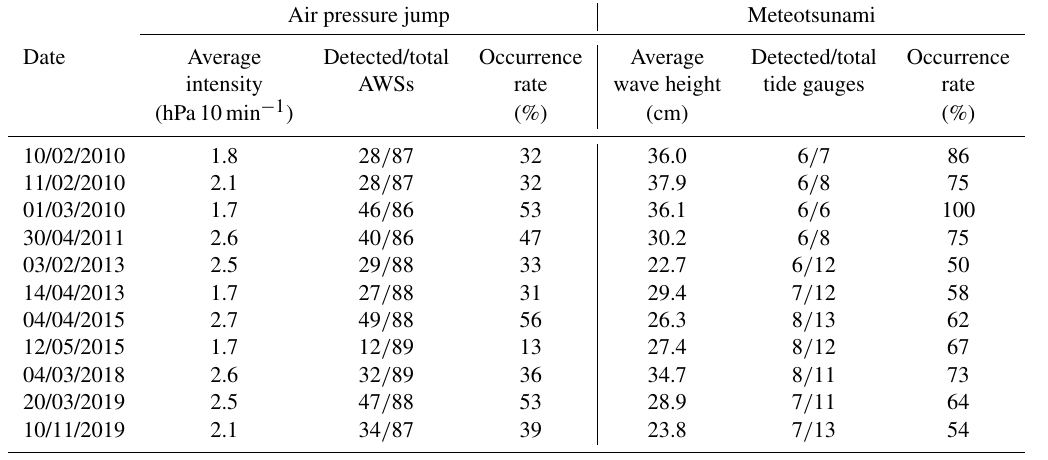
Table 2. Average intensity and occurrence rates for air pressure jumps and meteotsunamis during 11 extreme (widespread) meteotsunami events. The event dates are presented in day/month/year format.